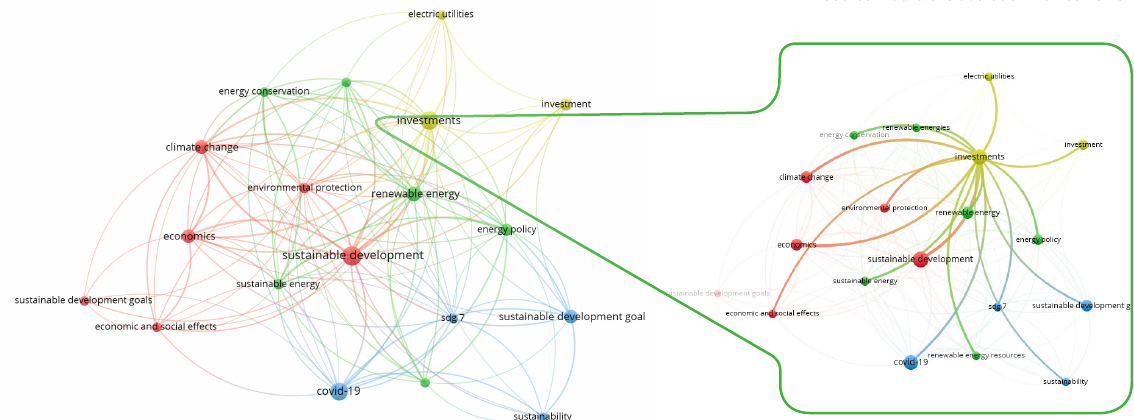
Figure 5. Co-occurrence map of SDG 7 publications and investment related research